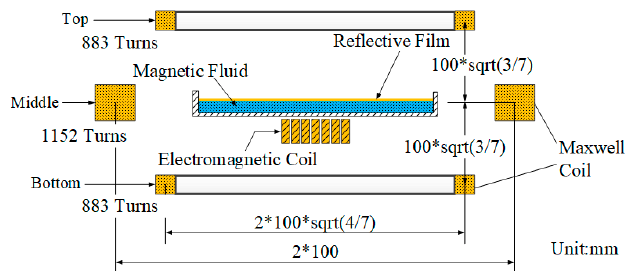
Figure 3. The schematic diagram of the MFDM.